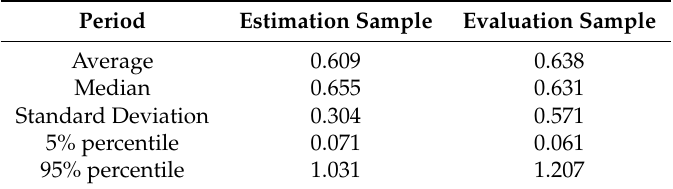
Table 6. A summary of results on median FE 2 , the median ratio of squared analyst forecast error over PCE 2 squared predictable component error. The analyst forecast is the earnings forecast that is reported